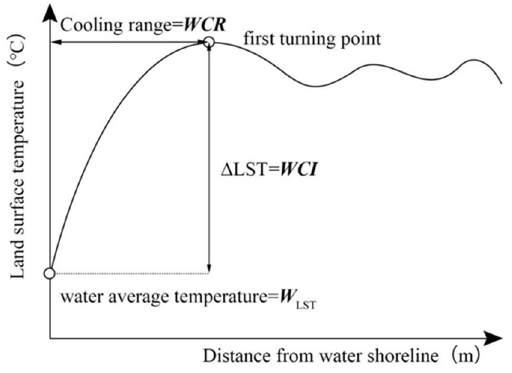
Figure 4. The schematic diagram of the cooling intensity and the cooling range.